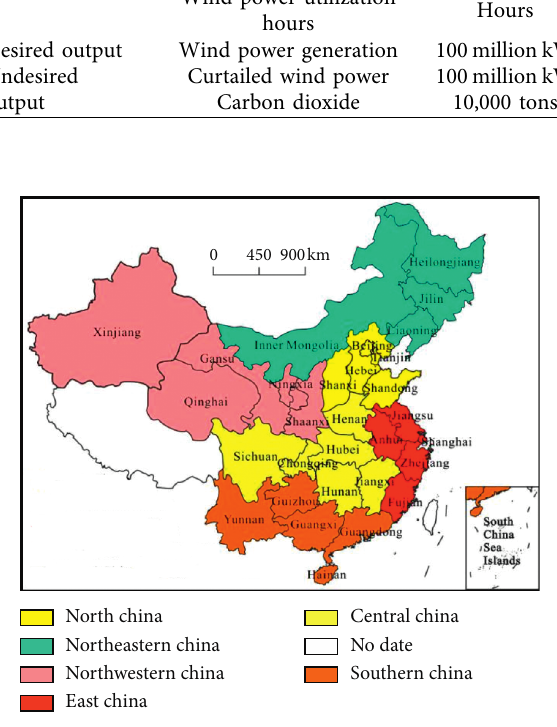
Figure 3: Six regions of